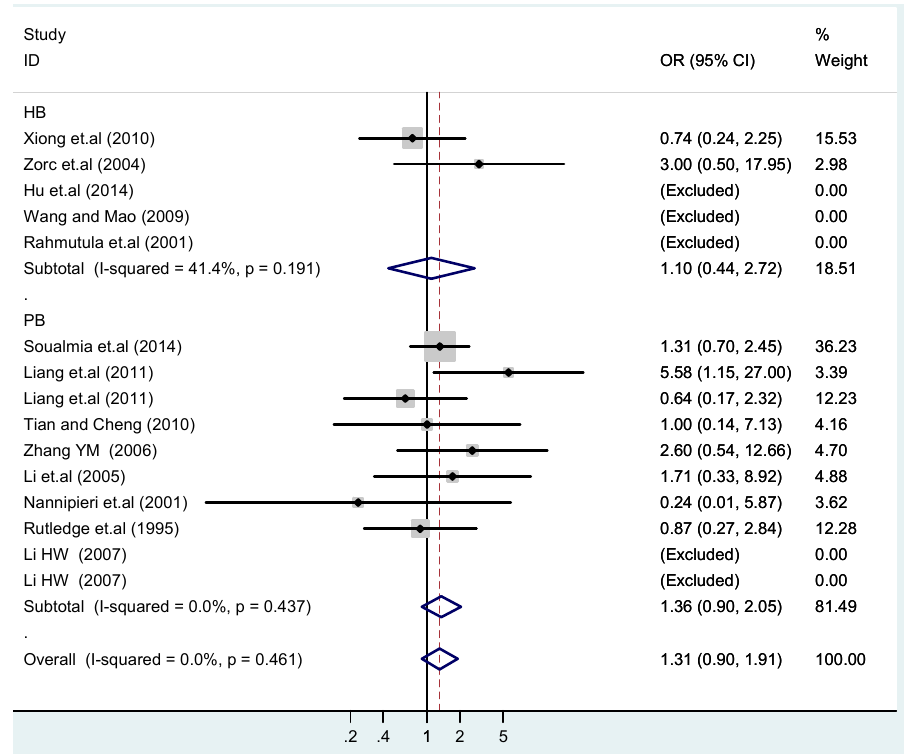
Figure 15. Subgroups in sources of controls of T2238C co-dominant model-1 (TC vs. TT). Int. J. Environ. Res. Public Health 2016 , 13 , 458